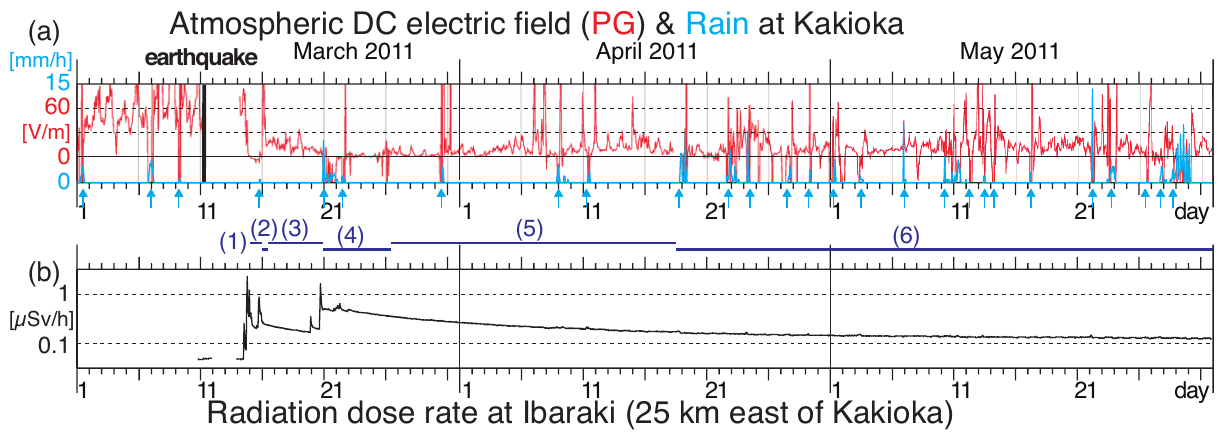
Fig. 1. Three months data before and after the M9.0 earthquake on 11 March 2011: (a) Atmospheric DC electric field vertical component, or potential gradient (PG) at Kakioka station measured by electrostatic sensor (red line) and rainfall at Kakioka (blue line); (b) the radiation dose rate at Ibaraki-cho (nearest station of radiation observation to Kakioka). The time resolutions of the plots are 1h (PG data is sampled with 1s resolution). The blue vertical arrows below the upper panel indicate the onset of rain events. The numbers (1) to (6) between two panels refer to the six time segments as described in the text and designated by the stepped horizontal lines. The data gap from 06UT, 11 March to 06UT, 14 March is due to the power failure caused by the